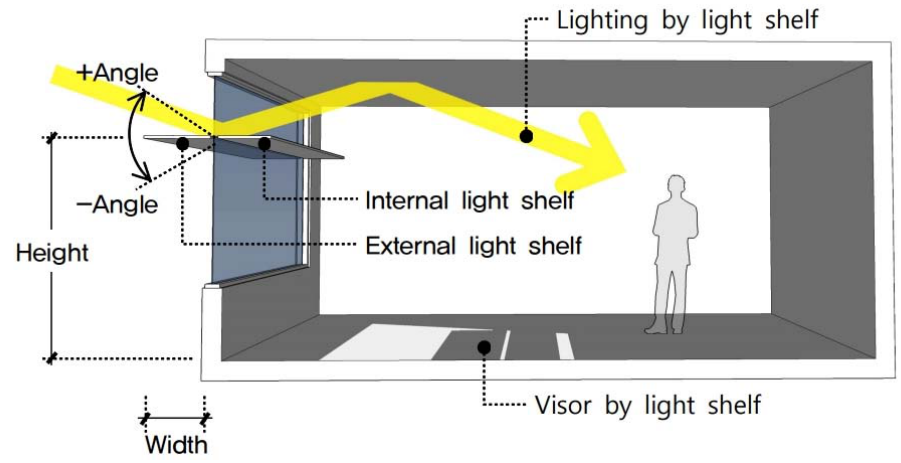
Figure 1. Light shelf concept and variables.